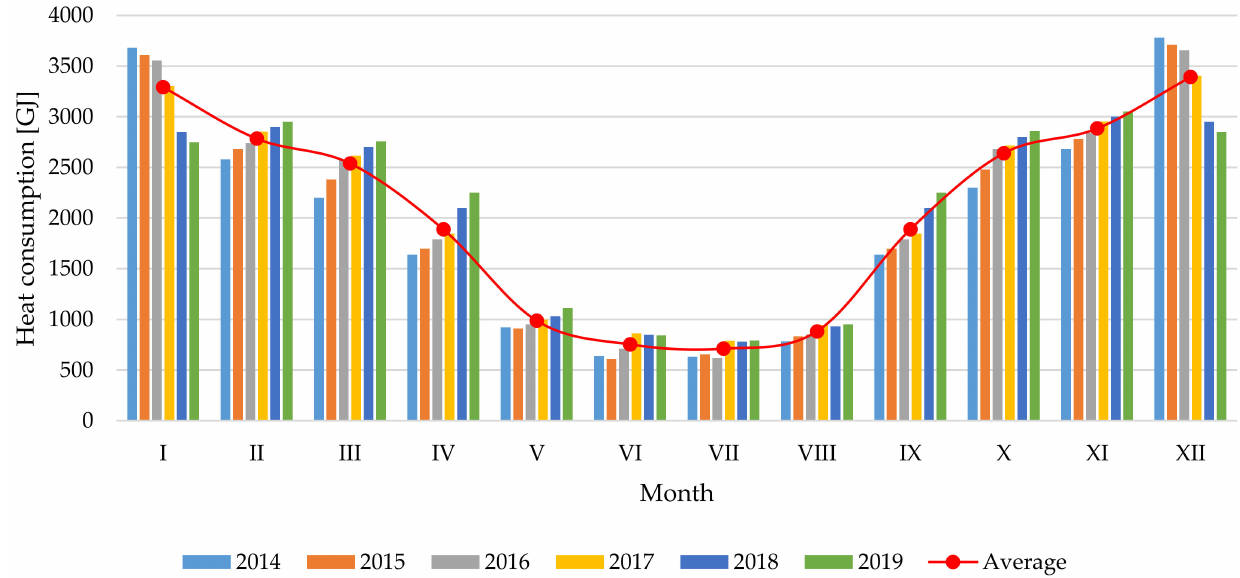
Figure 3. Measured heat consumption in